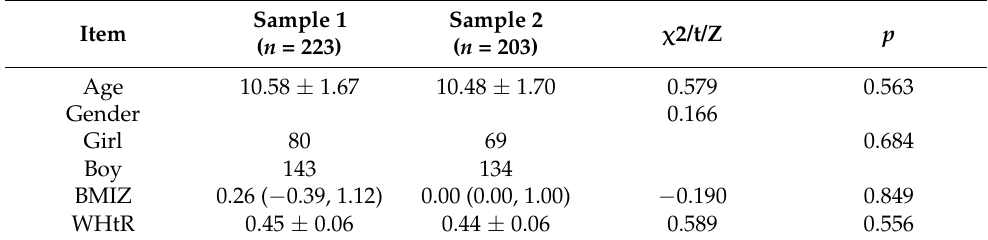
Table 1. The invariance comparison of the two